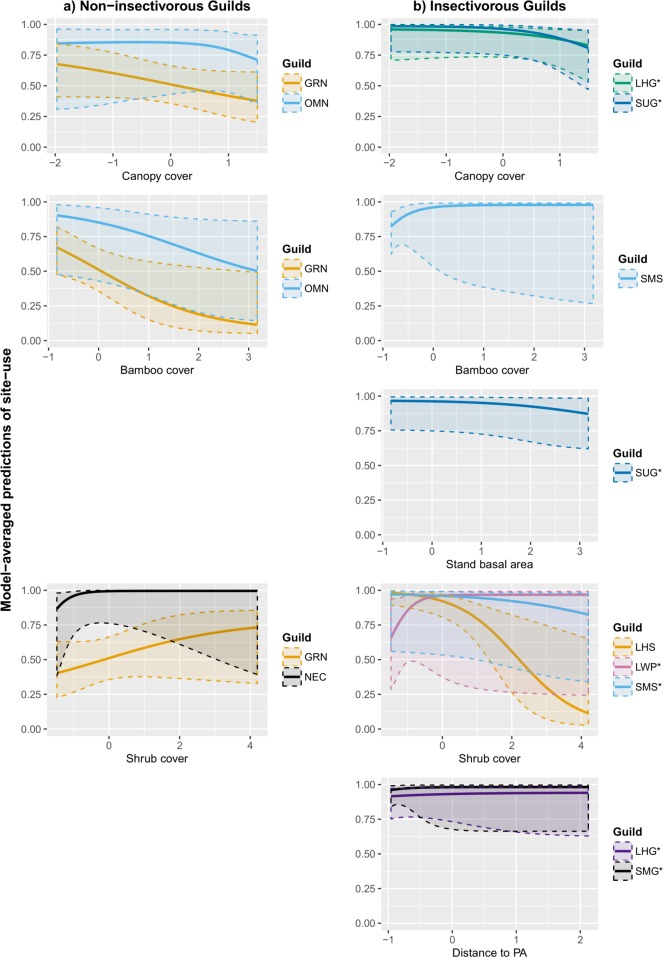
Predicted site-use of a) non-insectivorous guilds and b) insectivorous guilds as a function of vegetation and proximity effects as estimated through single-season occupancy models. Predictions were model-averaged across all converged models; shaded regions represent associated standard errors. Covariates were standardized to have a mean of 0 and standard deviation of 1. Guilds where covariate effect has weak support are marked with an asterisk (‘*’). Guilds where covariate effect is unsupported are not included. Guild abbreviations: NEC (Nectarivores), GRN (Granivores), OMN (Omnivores), FRG (Frugivores), LHG (Large high-canopy gleaning insectivores), LUG (Large understory gleaning insectivores), LHS (Large high-canopy sallying insectivores), SMG (Small mid-canopy gleaning insectivores), SUG (Small understory gleaning insectivores), SMS (Small mid-canopy sallying insectivores), LWP (Large woodpeckers).